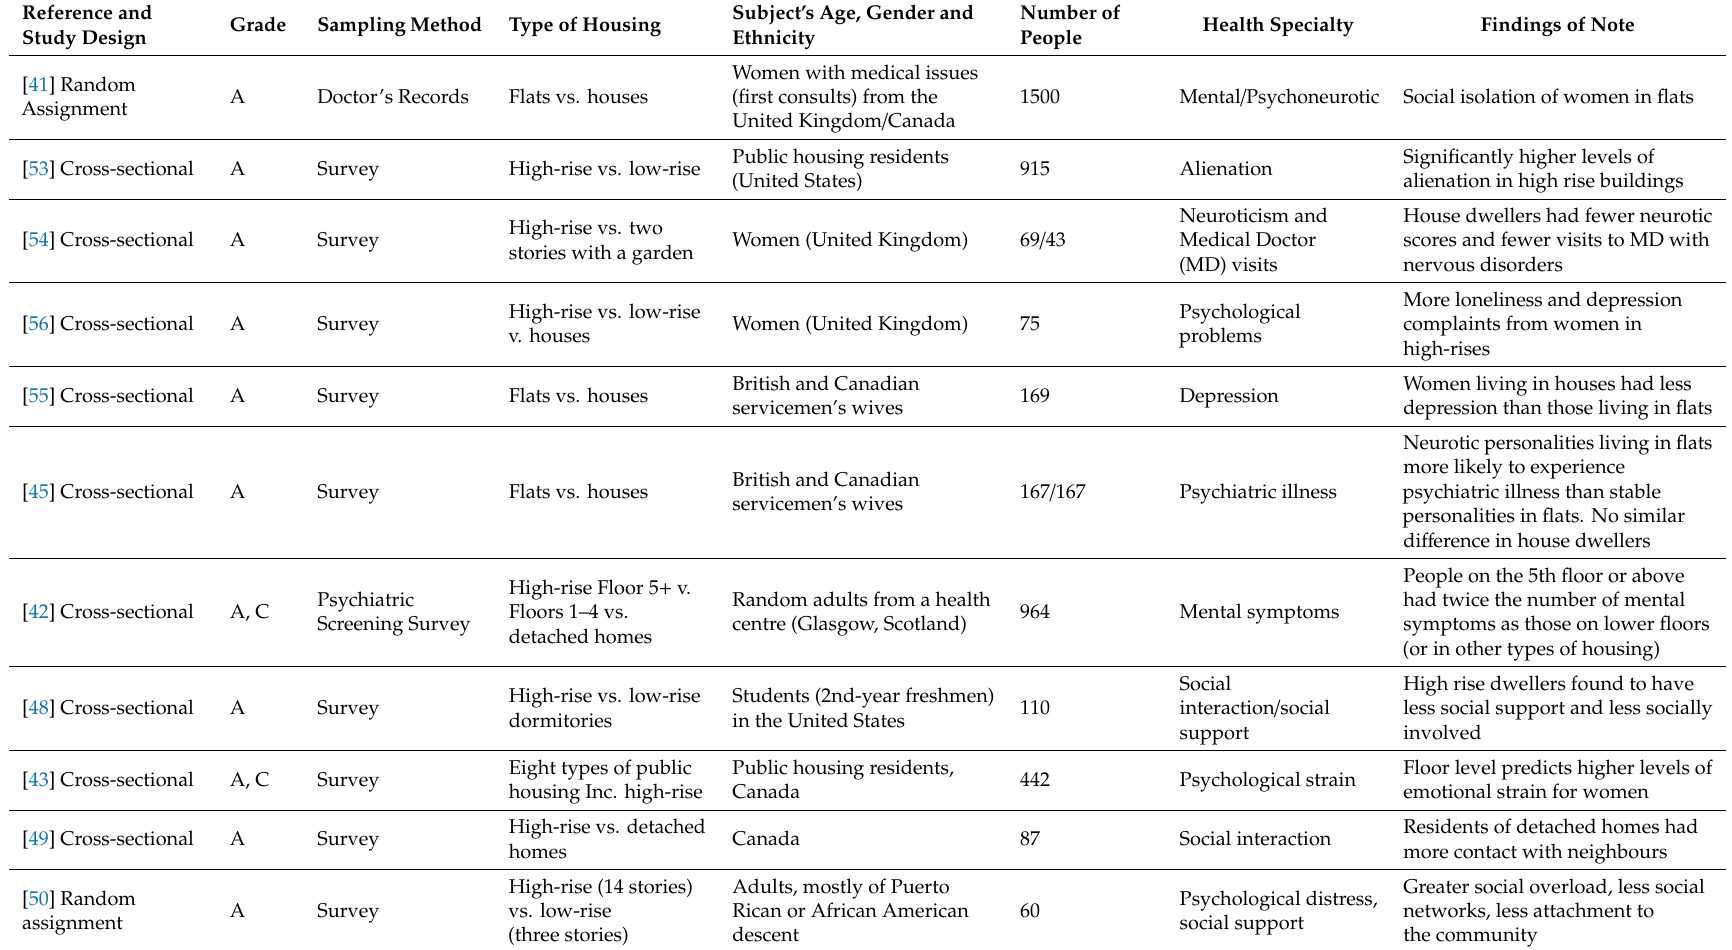
Table A2. Summary of findings for articles assessing the relationship between high-rise housing and mental health (n =